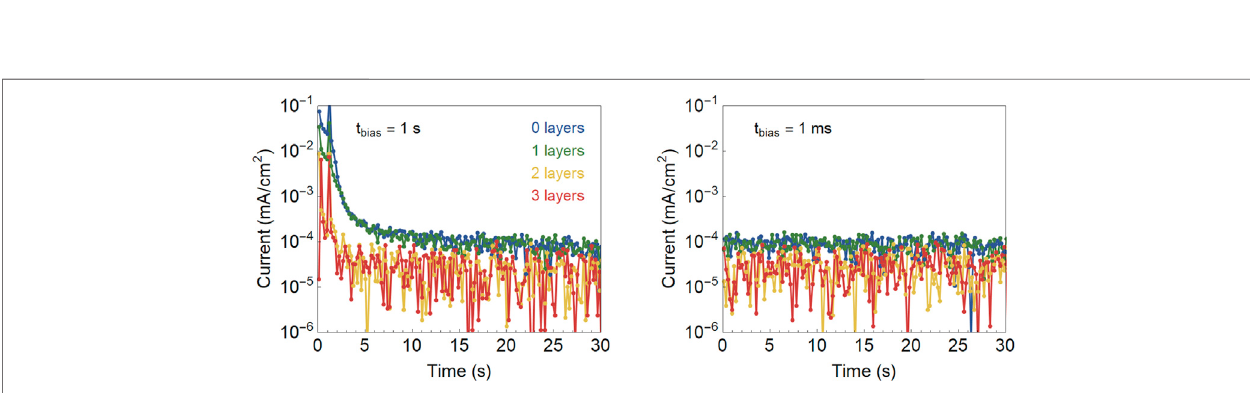
FIGURE 4 | Transient current measurements from MOS capacitors with alternating bilayer dielectric thicknesses.